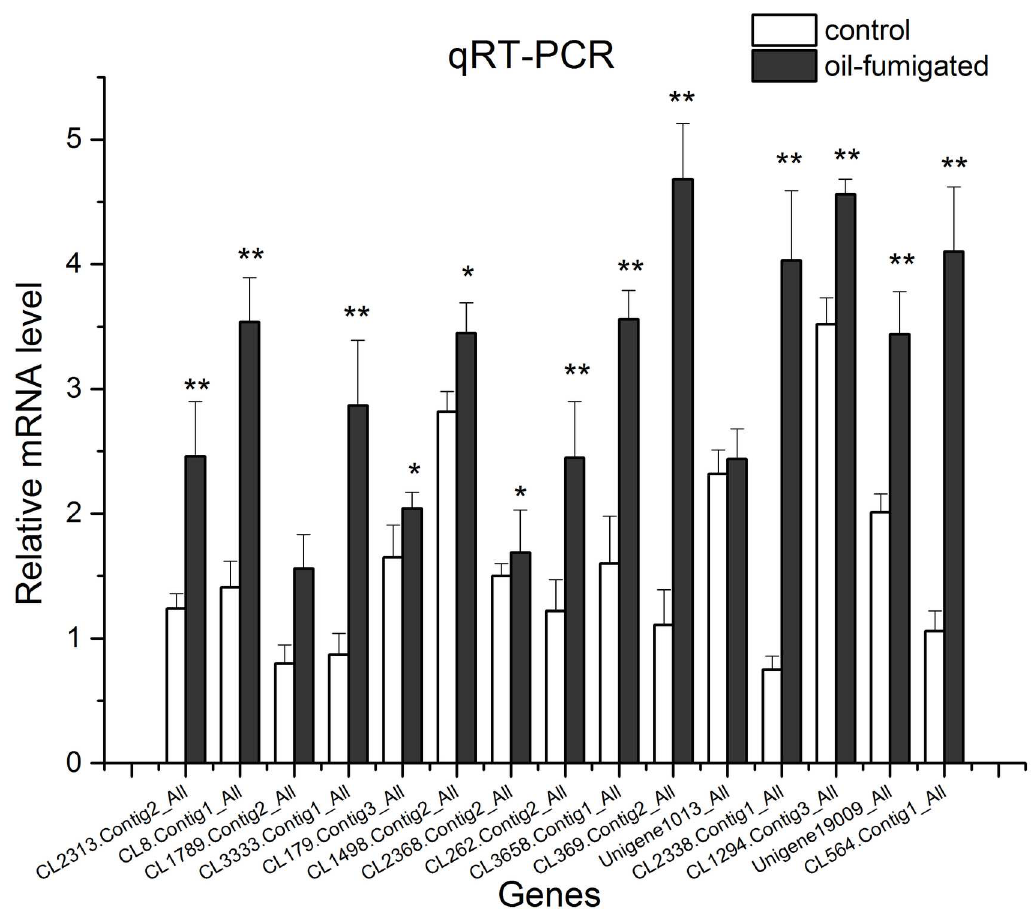
Fig 4. Real-time qRT-PCR analysis of DEGs encoding respiration and detoxification-related enzymesin S . zeamais after oil-fumigation. The gene expression(mean ± SD) quantified as a relative fold change was carried out using the 2 −ΔΔ CT method. The asterisks indicatesignificantdifferencesin the expressionlevel of DEGs betweenoil and no-oil treated samples ( * p value < 0.05 and ** p value <